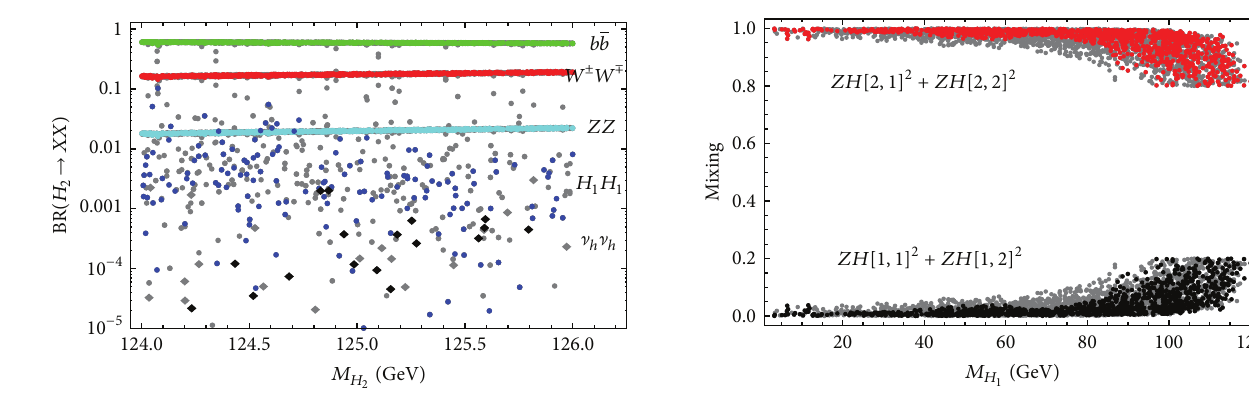
Figure 8: Mixing between scalar mass eigenstates and Higgs doublets (black: 𝐻 1 , red: 𝐻 2 ) and scalar doublet fields, as a function . 𝑍𝐻[𝑖,𝑗] is the scalar mixing matrix. Gray points are of 𝑀 𝐻 1 excluded by the low energy observables and by HiggsBounds .